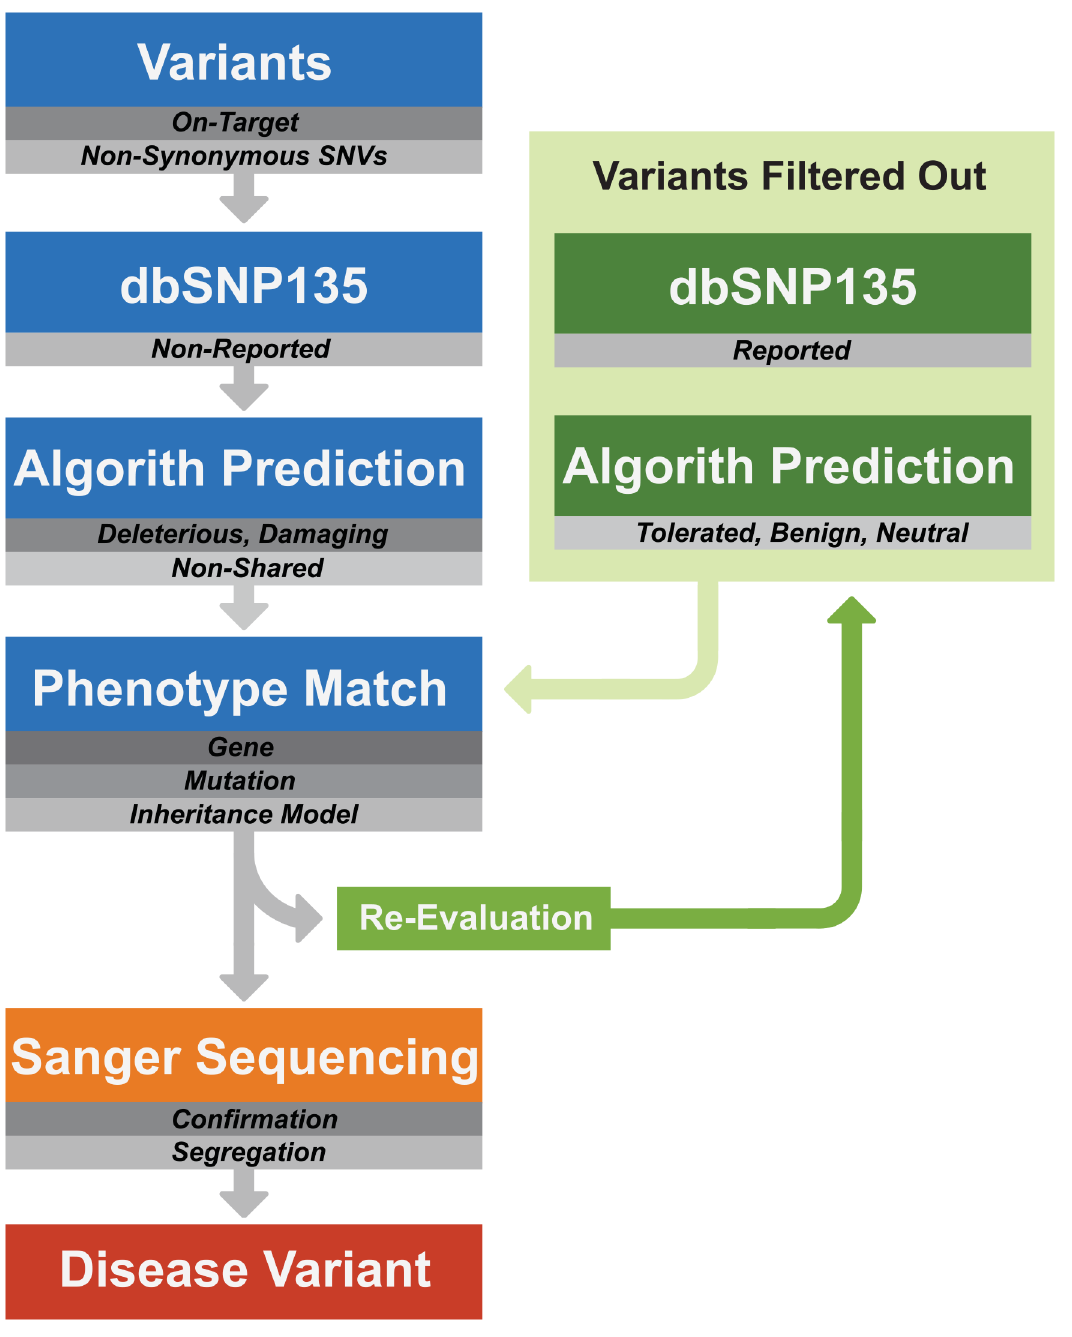
Fig 1. Analysis of the molecular data obtained by targeted exome